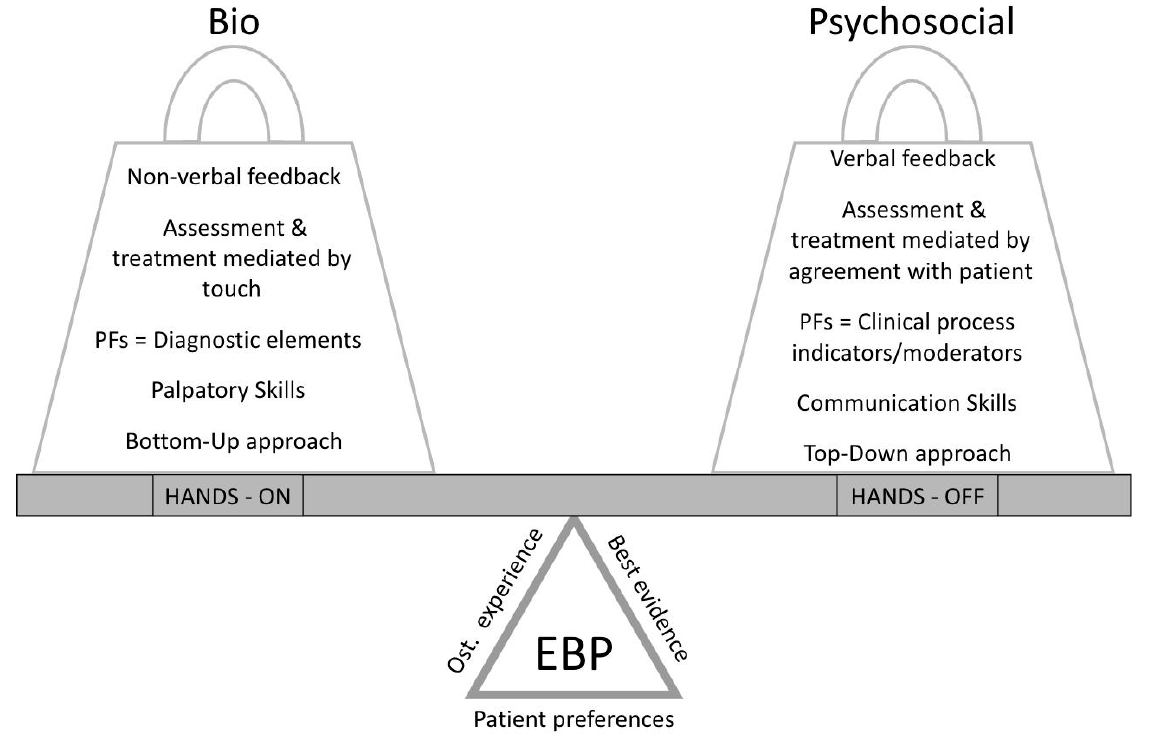
Figure 5. Evidence-based practice (EBP) plays a pivotal role in the balance of the osteopath’s competencies. PFs = palpatory findings.